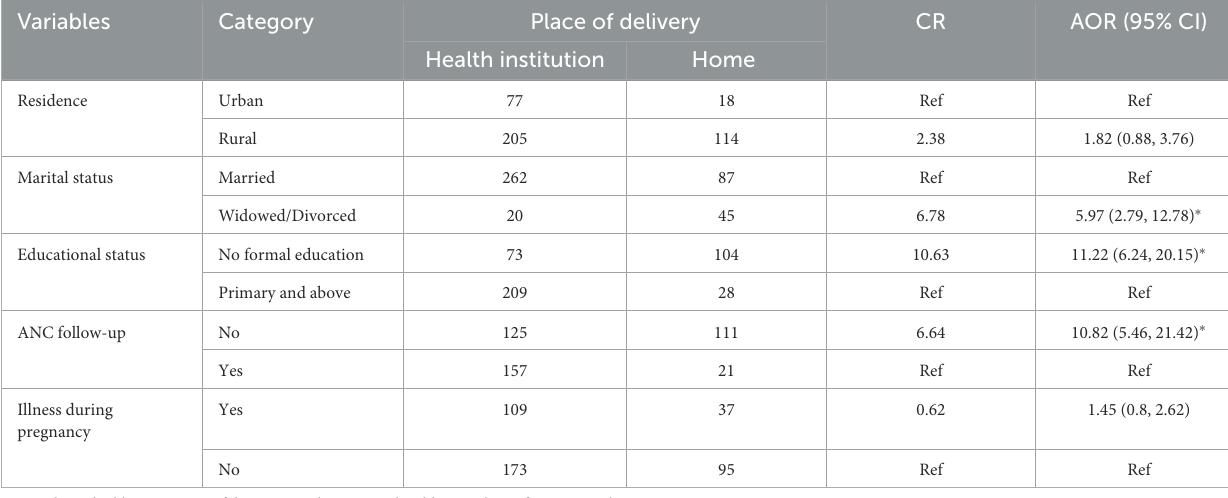
TABLE 4 Factors associated with home delivery among reproductive age women in southwest Ethiopia.